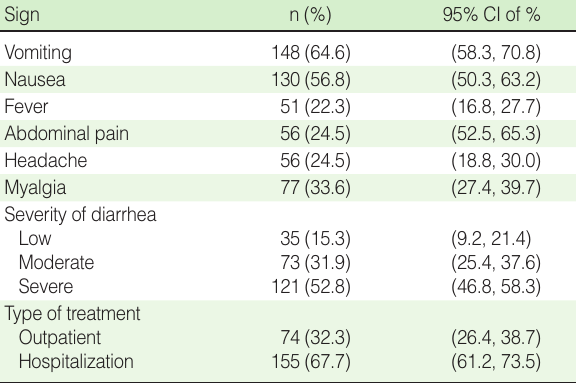
Table 2. Frequency of clinical signs, severity of diarrhea, and type of treatment of patients with cholera